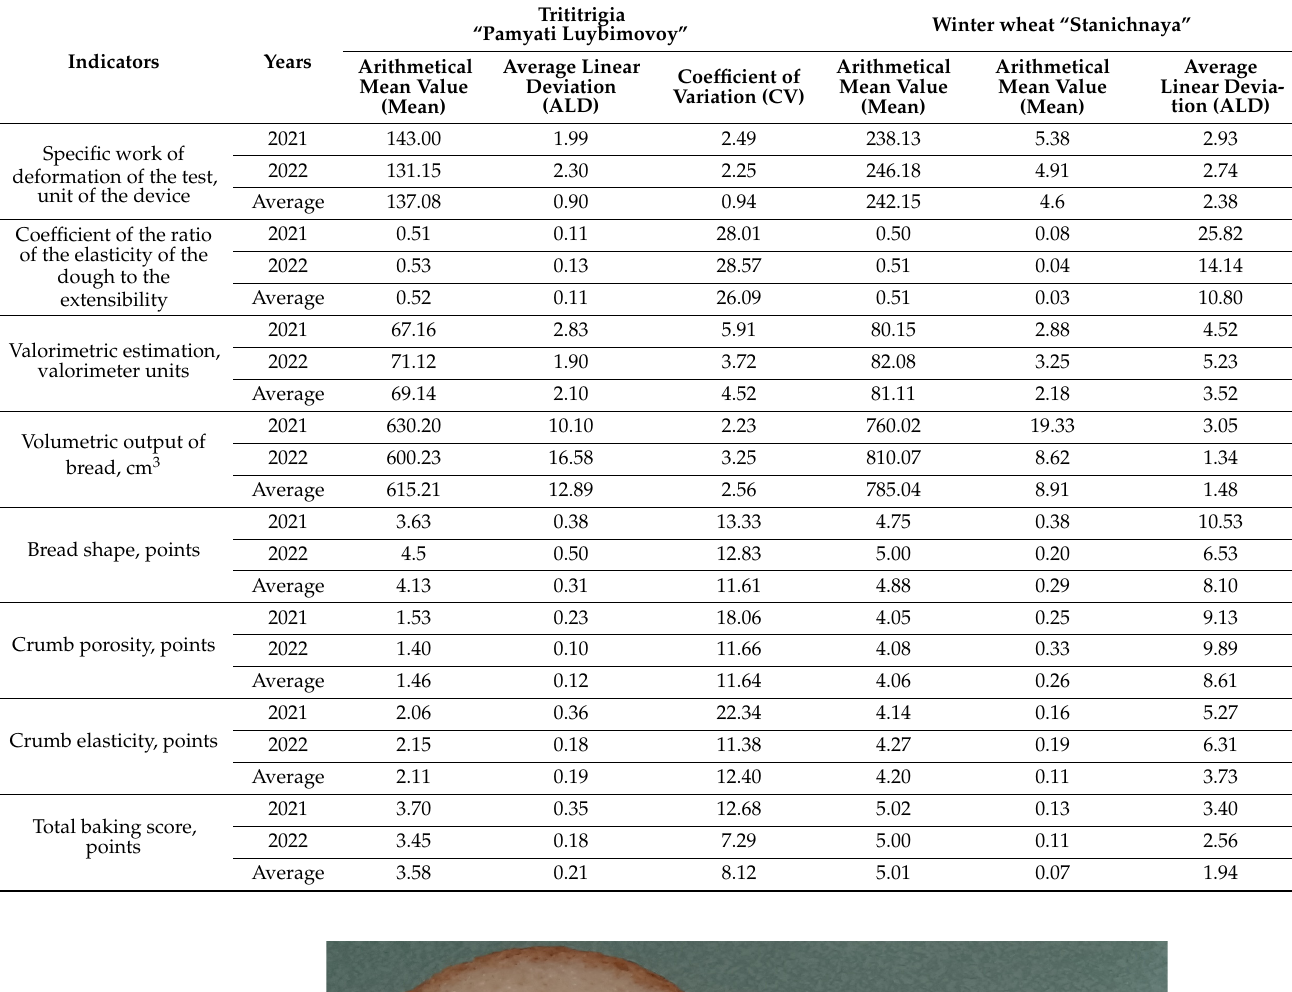
Table 4. Baking properties of Trititrigia and winter wheat.